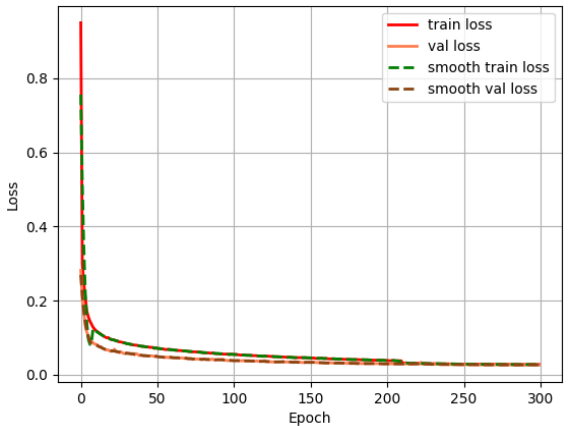
Figure 7. Loss convergence curve of CA-MobileNetv2-YOLOv4.